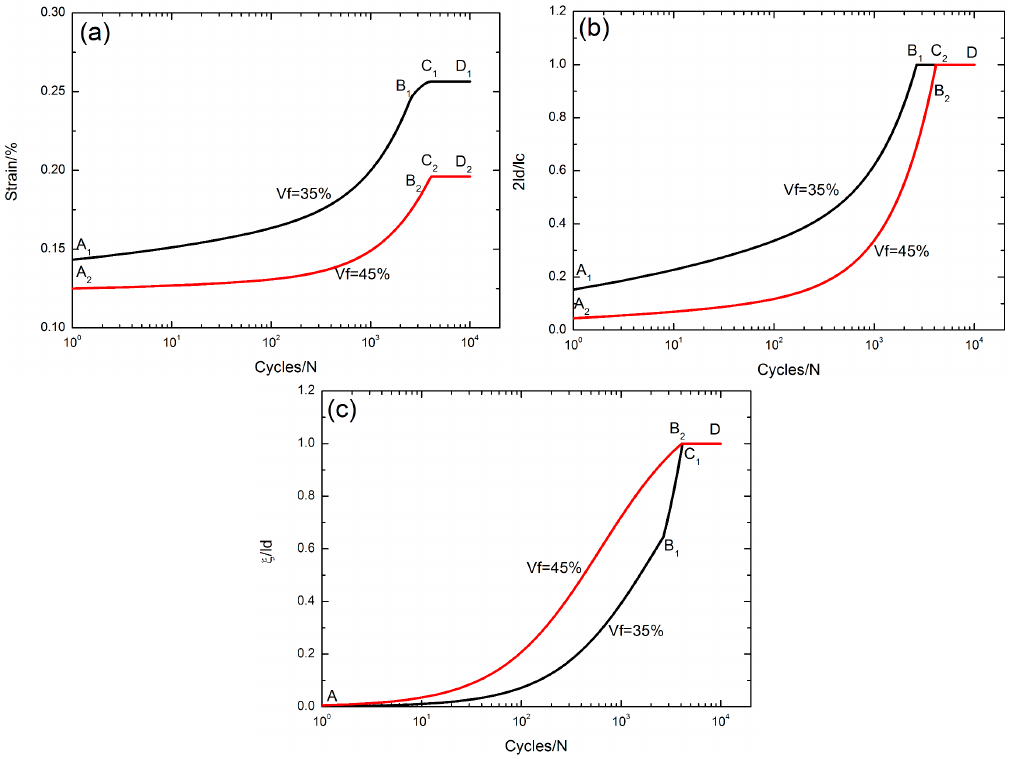
Figure 9. ( a ) The peak strain versus cycle number curves; ( b ) the interface debonded length 2 l d / l c versus cycle number curves; and ( c ) the interface oxidation length ξ / l d versus cycle number curves; corresponding to different fiber volume fractions of V f = 35% and 45% under σ max = 200 MPa with stress rupture time of 10 s at the oxidation temperature of Tem = 800 °C.